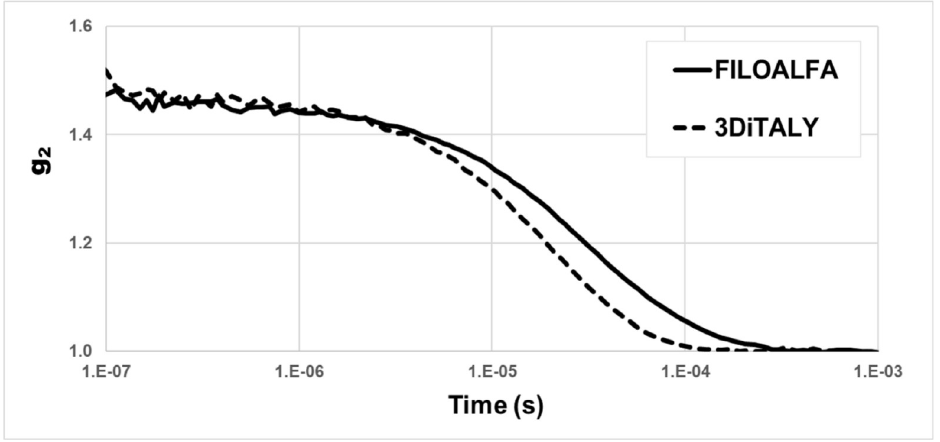
Fig 10. Intensity autocorrelation functions acquired with two probes printed with different PLA filaments: FILOALFA (solid line) and 3DiTALY (dashed line).